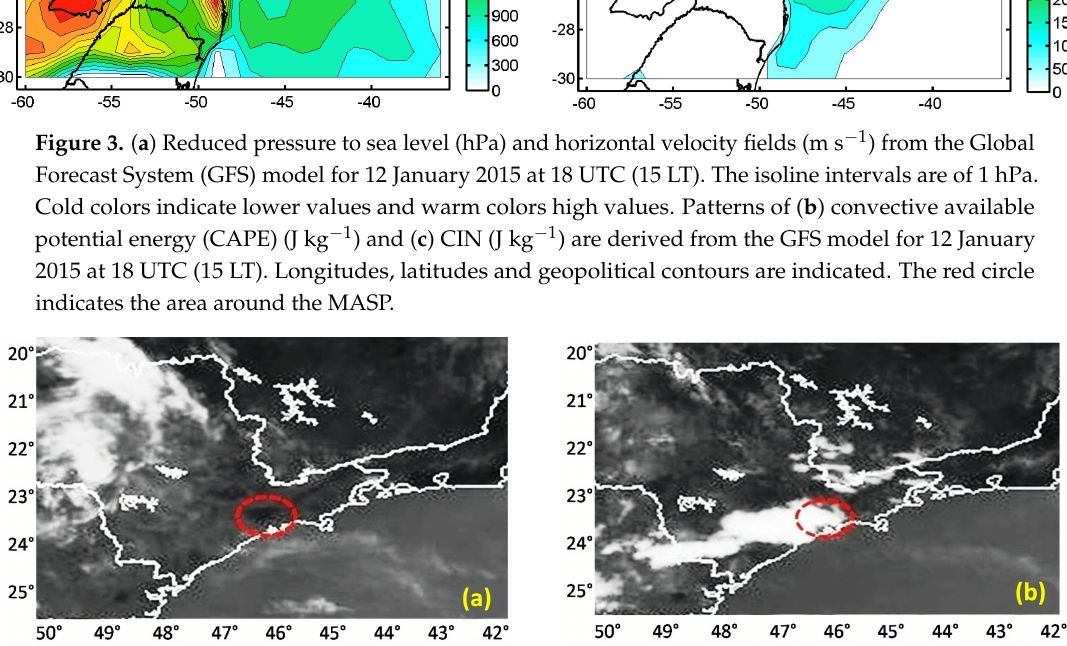
Figure 4. Images with high spatial resolution from the GOES-12 satellite for the infrared channel on 12 January 2015 at ( a ) 15 UTC (12 LT) and ( b ) 18 UTC (15 LT). The location of the MASP is highlighted with a red circle, where it is possible to observe the high temperatures at 1500 UTC. These figures were obtained from the web page of the CPTEC/INPE from Brazil